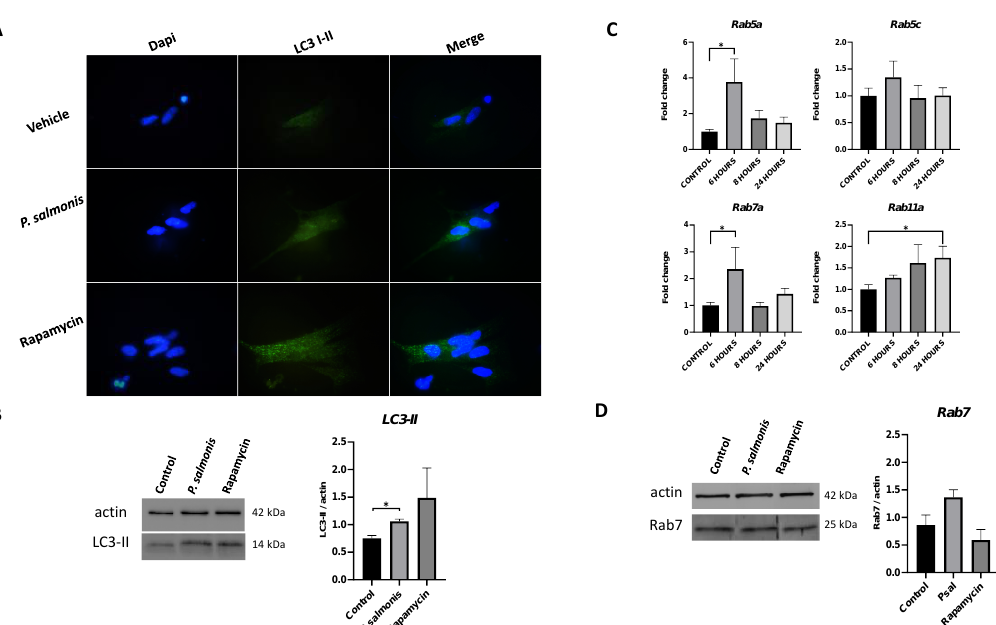
Figure 3. Effects of P. salmonis on the level of autophagy and Rab protein markers in muscle cells challenged. Fish skeletal muscle cells were cultured and challenge with P. salmonis at MOI 10 (re- suspended in differentiation medium) for 6 h. ( A ) Immunofluorescence of LC3 (LC3-I and LC3-II). ( B ) Representative Western blot of LC3-II. ( C ) Rab small GTPases gene expression and, ( D ) Represen- tative Western blot of Rab7a. The data are presented as the means ± SEMs of triplicates from three independent experiments, using fold change compared to the control values (untreated cells, n = 3). The measure of actin was used as load control for Western blots. qPCR analyses were normalized by the ef-1 α and β -actin genes. The difference between the control group and treated groups is denoted by asterisks (*) when the main effects were significant ( p < 0.05).